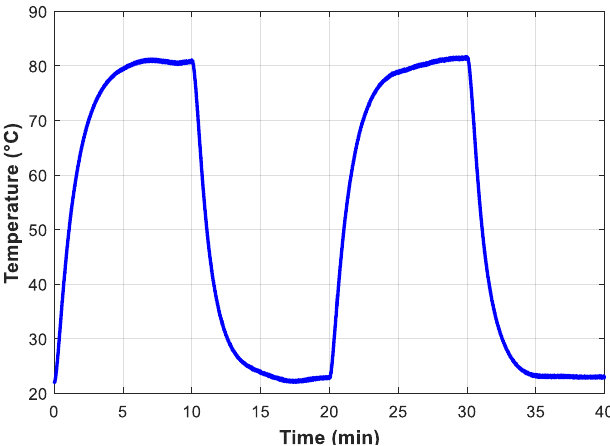
Figure 16. Temperature measured on the surface of the coil by Sensor T1 located on the outer surface of the coil.